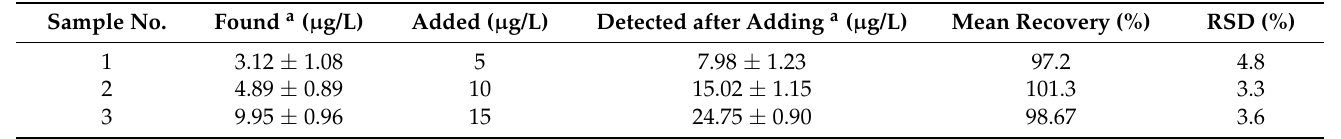
Table 1. Detection of As(III) in simulated river water.